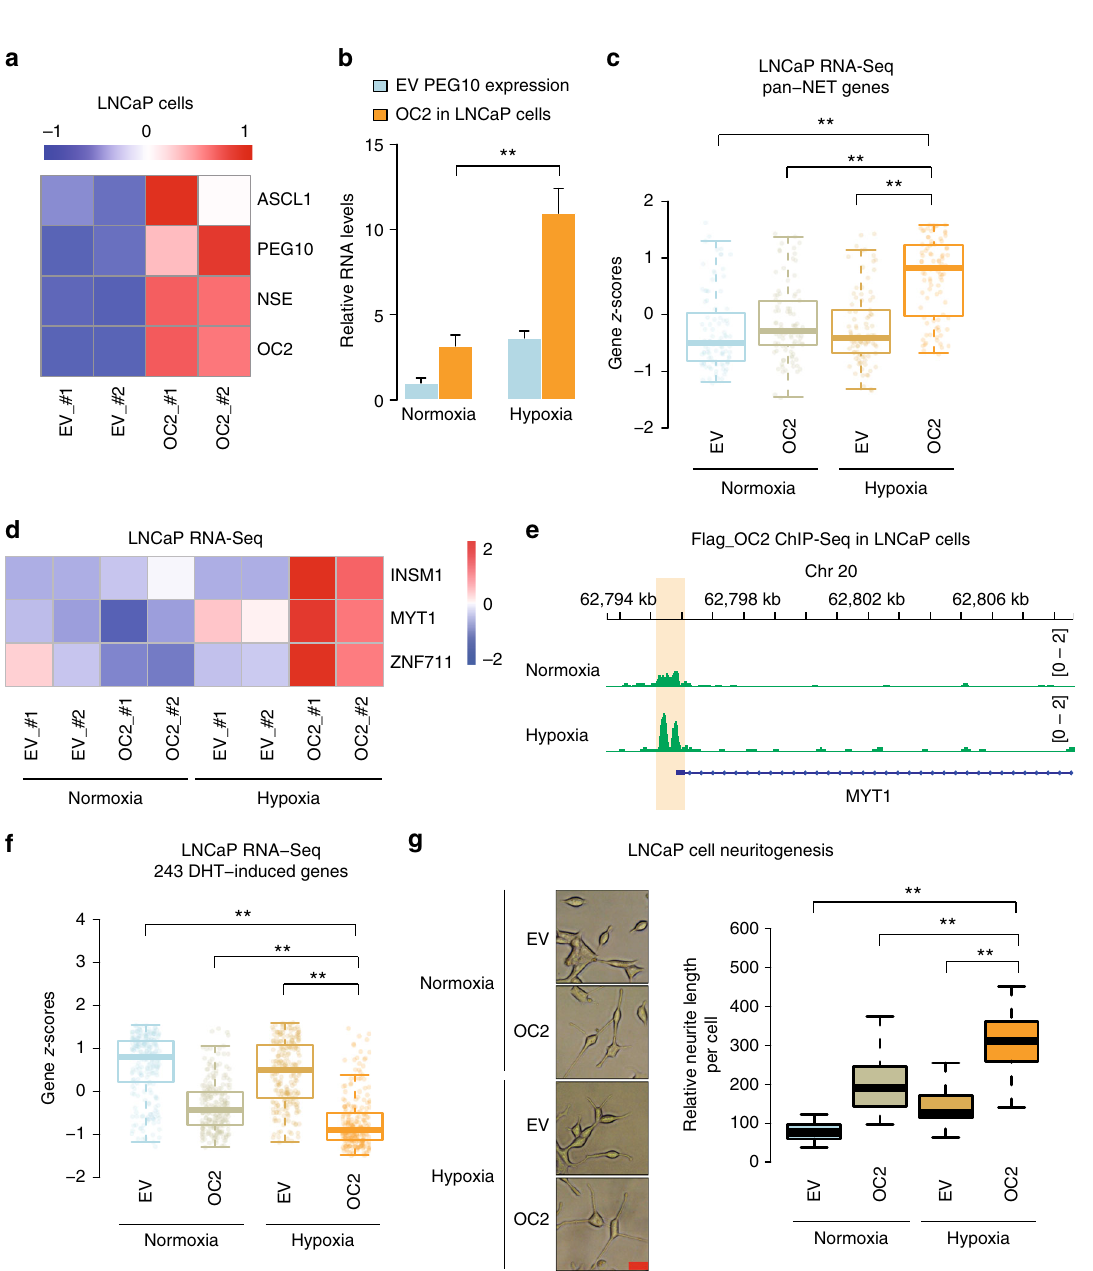
Fig. 4 ONECUT2 synergizes with hypoxia in driving neuroendocrine plasticity in prostatic adenocarcinoma. a NEPC marker gene expression in LNCaP cells. mRNA abundance as measured by RT-qPCR assay was fi rst normalized by housekeeping gene RPS28, and then z -score normalized; red represents higher signal and blue represents lower signal. b Expression of PEG10 in ONECUT2 overexpressing LNCaP cells under normoxic and hypoxic conditions. c Z- scores of the 92 pan-NET upregulated genes (ONECUT2 excluded) calculated in LNCaP RNA-Seq data. RNA-Seq experiments were performed in LNCaP cells with and without ONECUT2 overexpression under normoxic and hypoxic conditions. d Heatmap shows ONECUT2 overexpression and hypoxia synergistically promote expression of the core pan-NET transcriptional factors. e ONECUT2 ChIP-Seq signal at MYT1 promoter under normoxic and hypoxic conditions. f Z-scores of the 243 DHT-induced genes calculated in LNCaP RNA-Seq data. RNA-Seq experiments were performed in LNCaP cells with and without ONECUT2 overexpression under normoxic and hypoxic conditions. g Neuritogenesis analysis in LNCaP cell with and without overexpression of ONECUT2 under normoxic and hypoxic conditions. Error bars in b indicate s.d. from four technical replicates. P -values are calculated from a Student ’ s t -test in a and b and Wilcoxon rank sum test in c , f , and g . *: P < 0.05. **: P < 0.01. EV empty vector control, OC2 ONECUT2 overexpression. Source data are provided as a Source Data fi